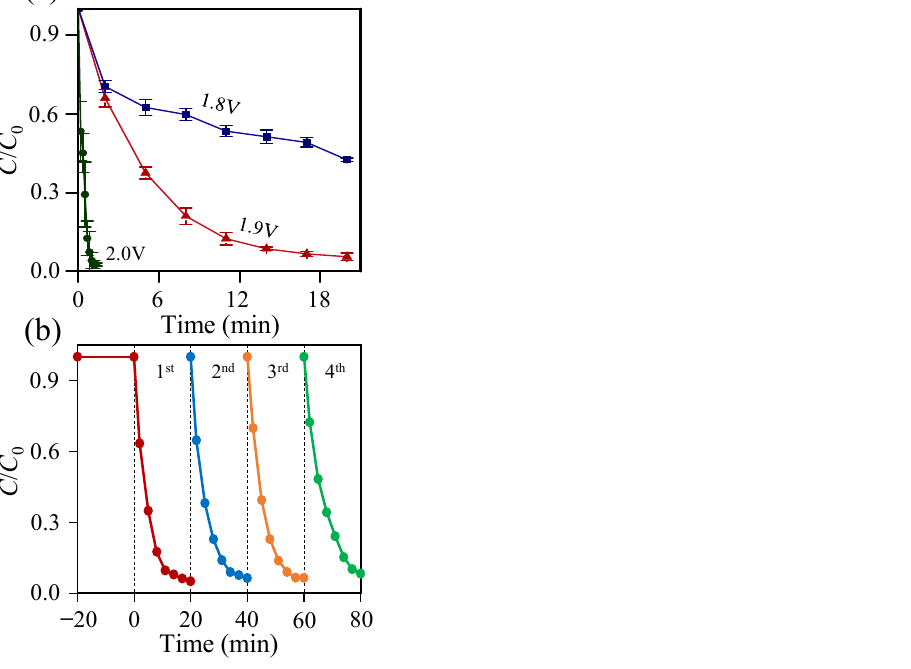
Figure 6. ( a ) C / C 0 vs. time during EC degradation of RhB over Fe 2 P-iron phosphate at different applied potentials in 0.06 M NaCl. ( b ) Recycling test for EC degradation of RhB over Fe 2 P-iron phosphate in 0.06 M NaCl at 1.9 V vs. RHE.